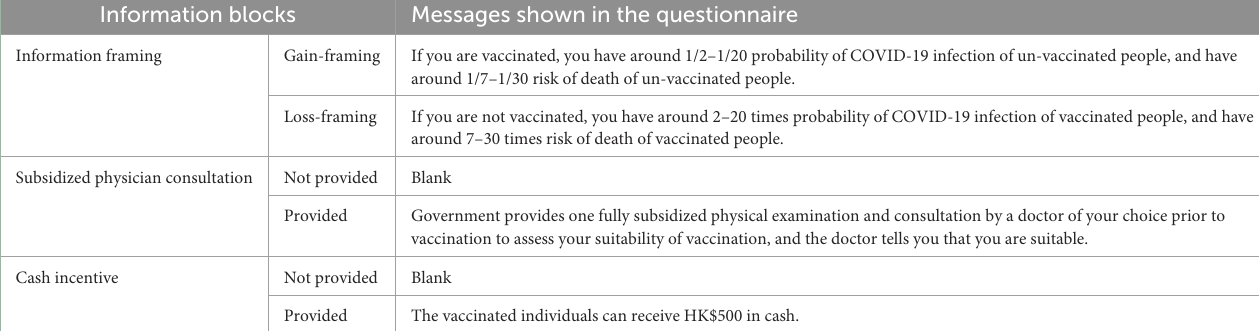
TABLE 1 Messages on the three strategies used in the survey